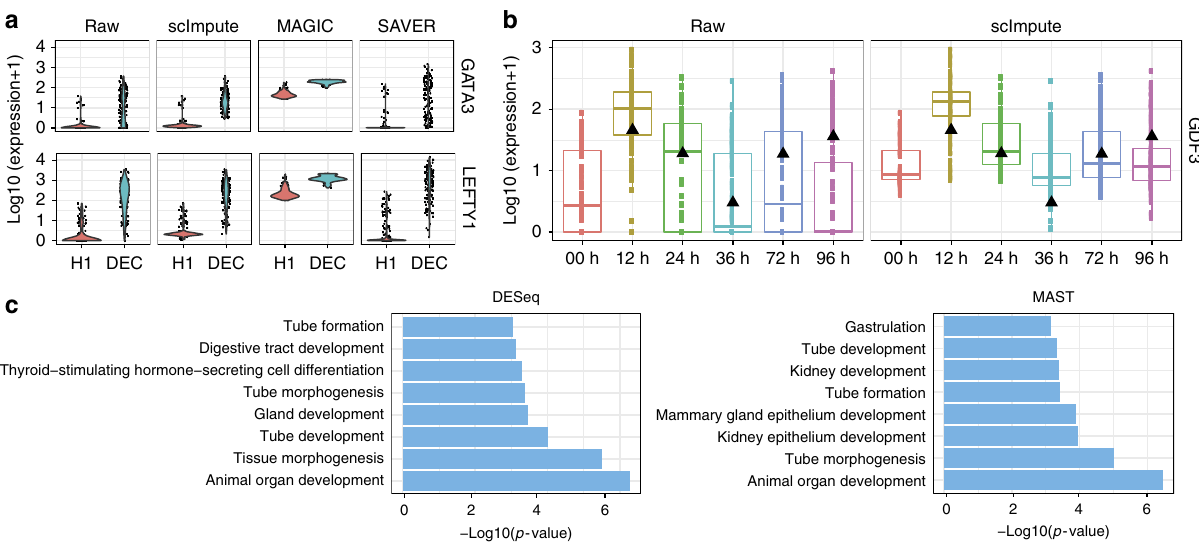
Fig. 7 scImpute improves differential gene expression analysis and reveals expression dynamics in time-course experiments. a Raw and imputed expression levels of two marker genes of DEC. b Time-course expression patterns of the gene GDF3 , which is annotated with the GO term “ endoderm development. ” Black triangles mark the gene ’ s expression in bulk data. c Selected GO terms enriched in the DEC-upregulated genes that can be only detected (by DESeq2 or MAST) in the imputed data by scImpute, but not in the raw